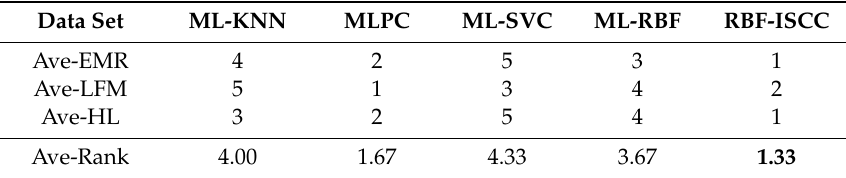
Table 12. Ranking of di ff erent methods for multi-label data